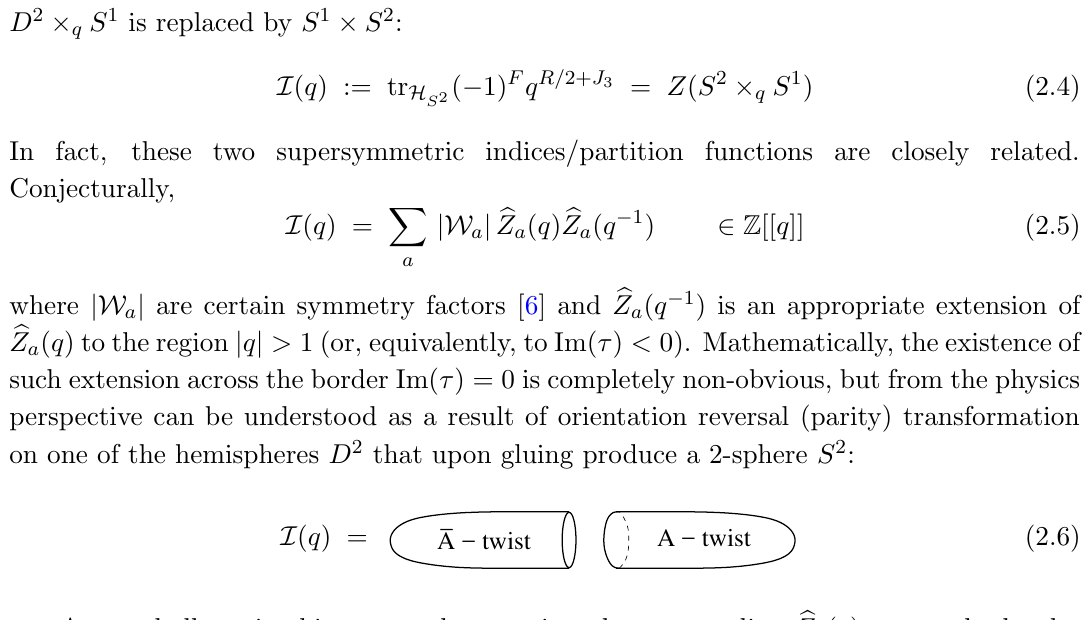
Figure 3 . A homological block (a.k.a. half-index) counts BPS states of 3d (time) (cid:2)